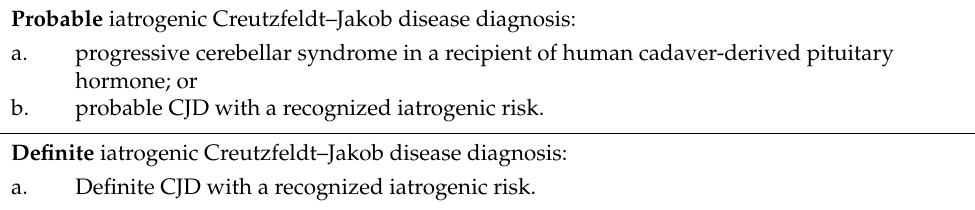
Table 2. Diagnostic criteria for probable and definite